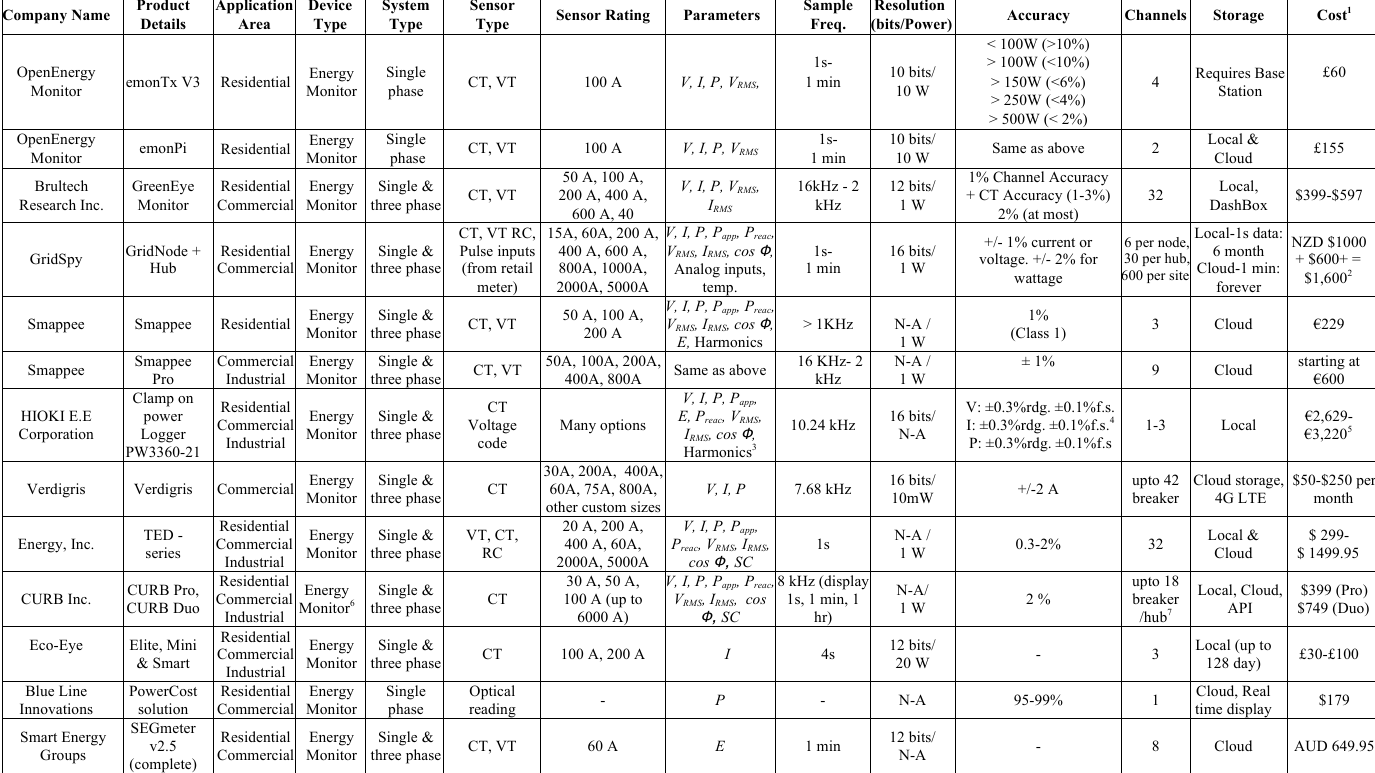
Figure A1. Technical